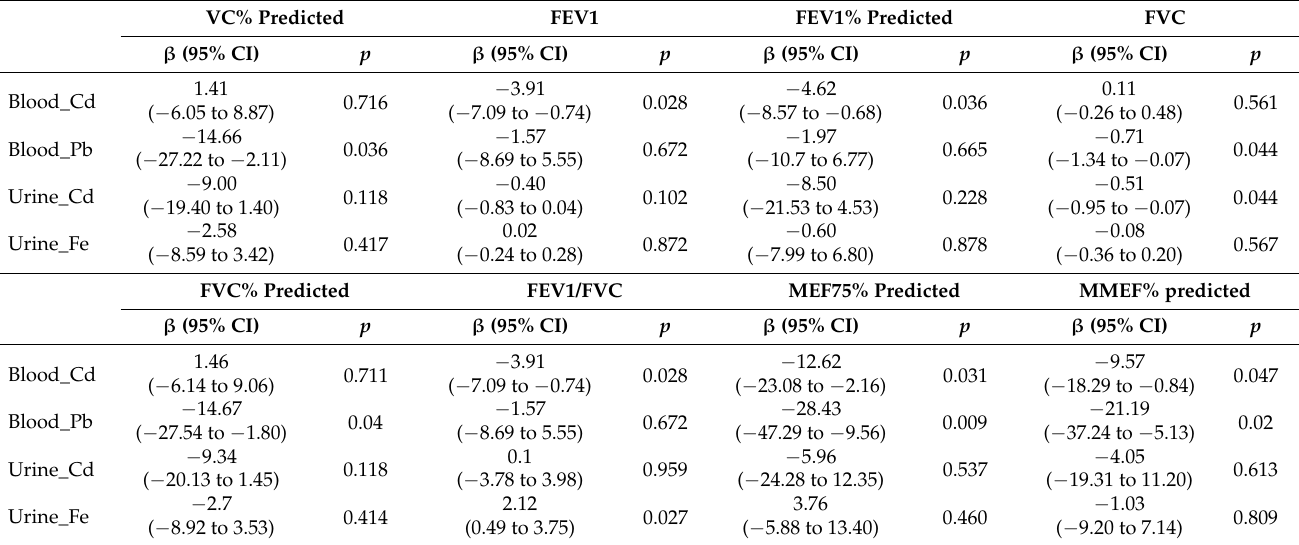
Table 3. The association between metal levels and lung function in cases with welder’s pneumoconiosis.